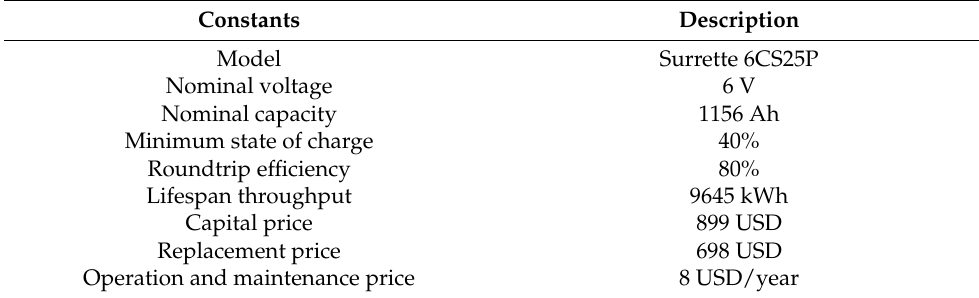
Table 3. Cost and technical data of the storage.